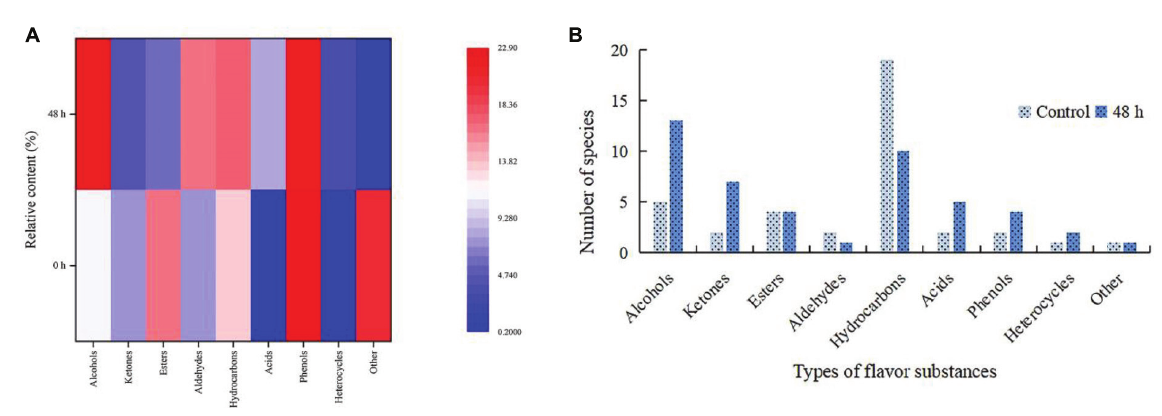
hydrolysis during fermentation (33). Under the catalytic reaction, the proteases could degrade the protein into smaller peptides that are degraded into the small-molecule free amino acids by the action of the peptidase (34). end of fermentation ( Table 2 ). ( Table 4 ). Glutamate, free histidine and alanine levels decreased